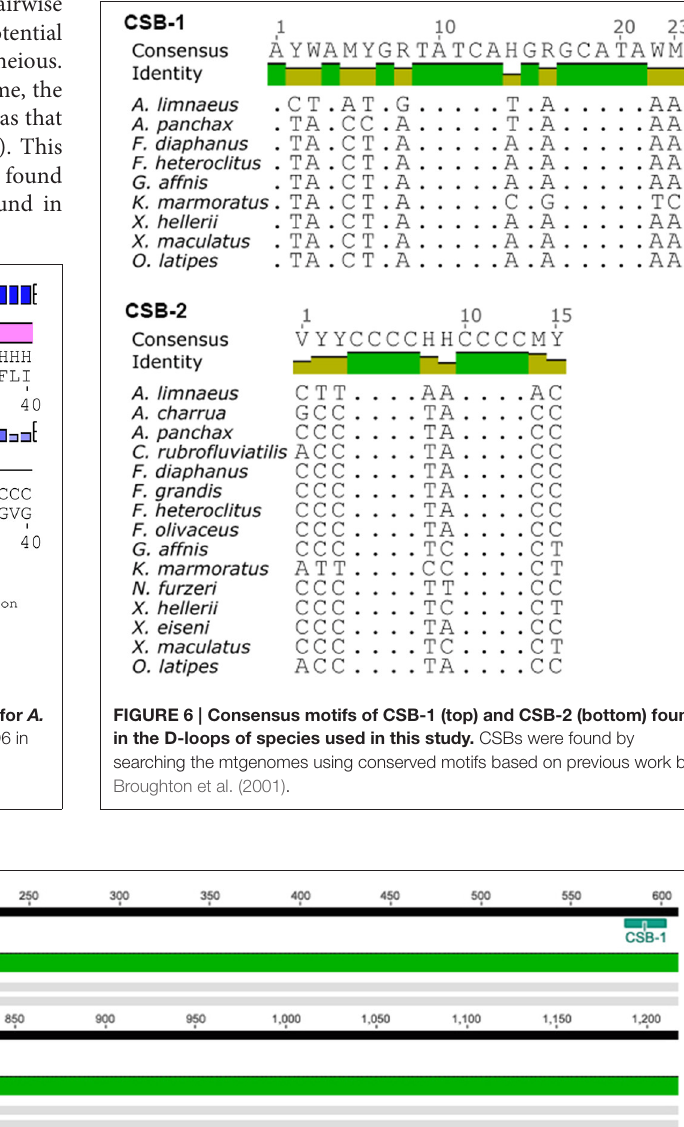
Frontiers in Physiology |